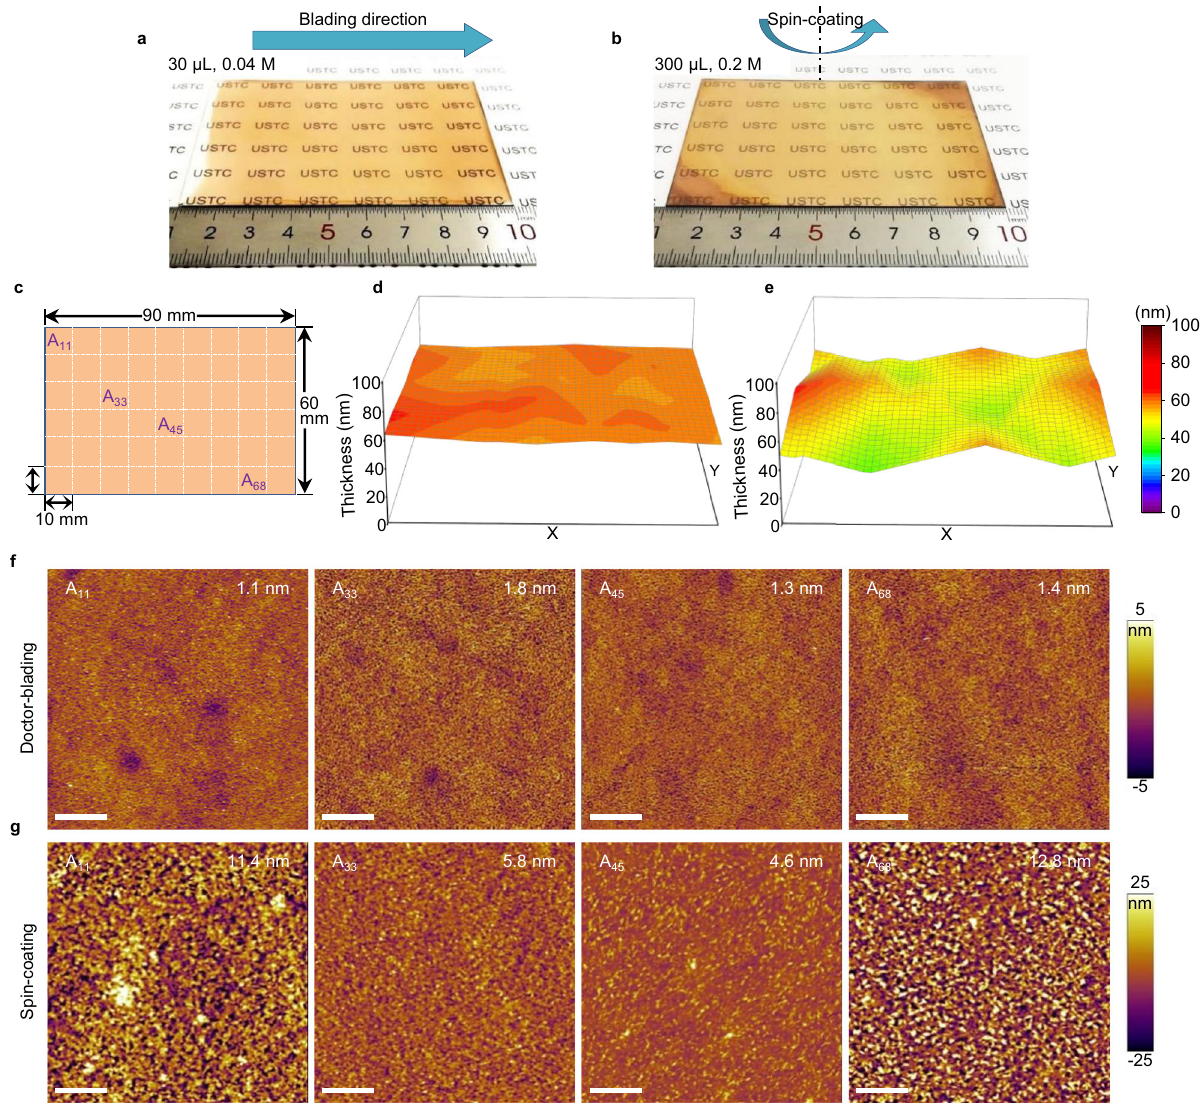
Fig. 3 Morphology characterizations of large-area perovskite fi lms. a , b Photo images of the large-area perovskite fi lms fabricated by doctor-blading ( a ) and spin-coating ( b ). The fi lm area is 6 × 9 cm 2 . The volume and concentration of the precursor solution needed to prepare the fi lms are also marked in the images. c Schematics of the large-area fi lm divided to 1 × 1 cm 2 pieces. Each pieces are marked as A xy ( x , y = 1, 2, 3 … ). d , e Thickness mapping of the large- area fi lms fabricated by doctor-blading ( d ) and spin-coating ( e ). The thicknesses of each small-area fi lms (56 fi lms in total) are measured separately. The three-dimensional fi gures are plotted by spatial interpolation. f , g AFM images of the large-area fi lms fabricated by doctor-blading ( f ) and spin-coating ( g ). The number of small-area fi lms and roughness are marked in the images. All scale bars are 5 µ